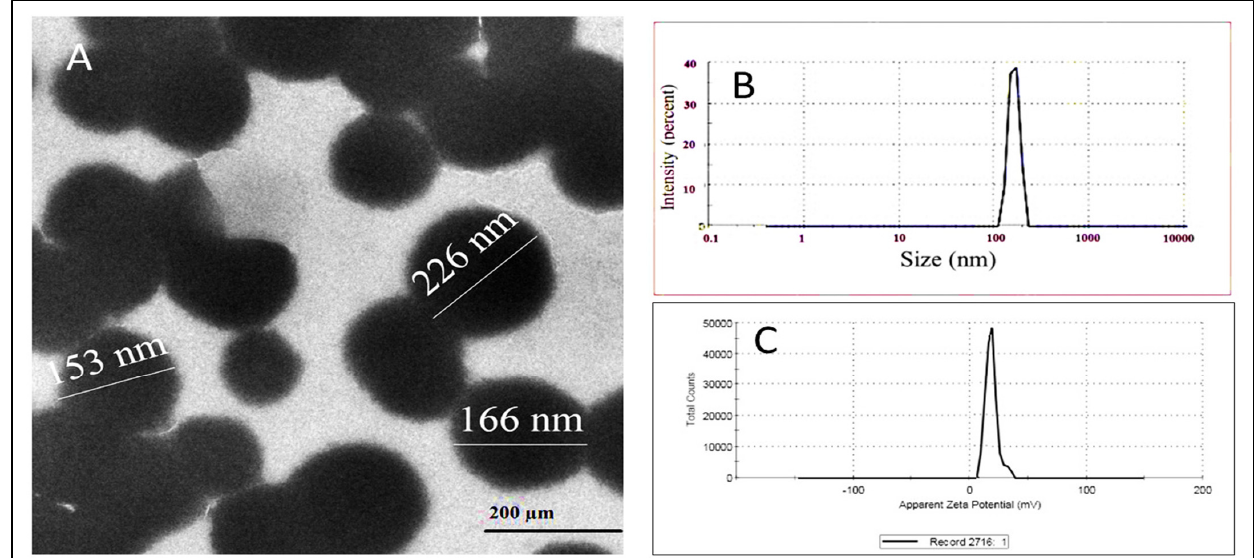
Figure 3. Characterization of GM–AA–CSNPs. ( A ): TEM image; ( B , C ): Zeta potential.